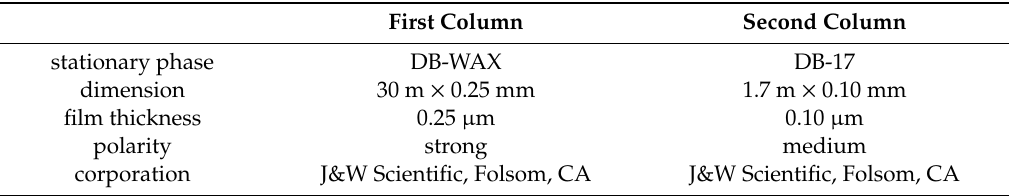
Table 5. GC × GC column